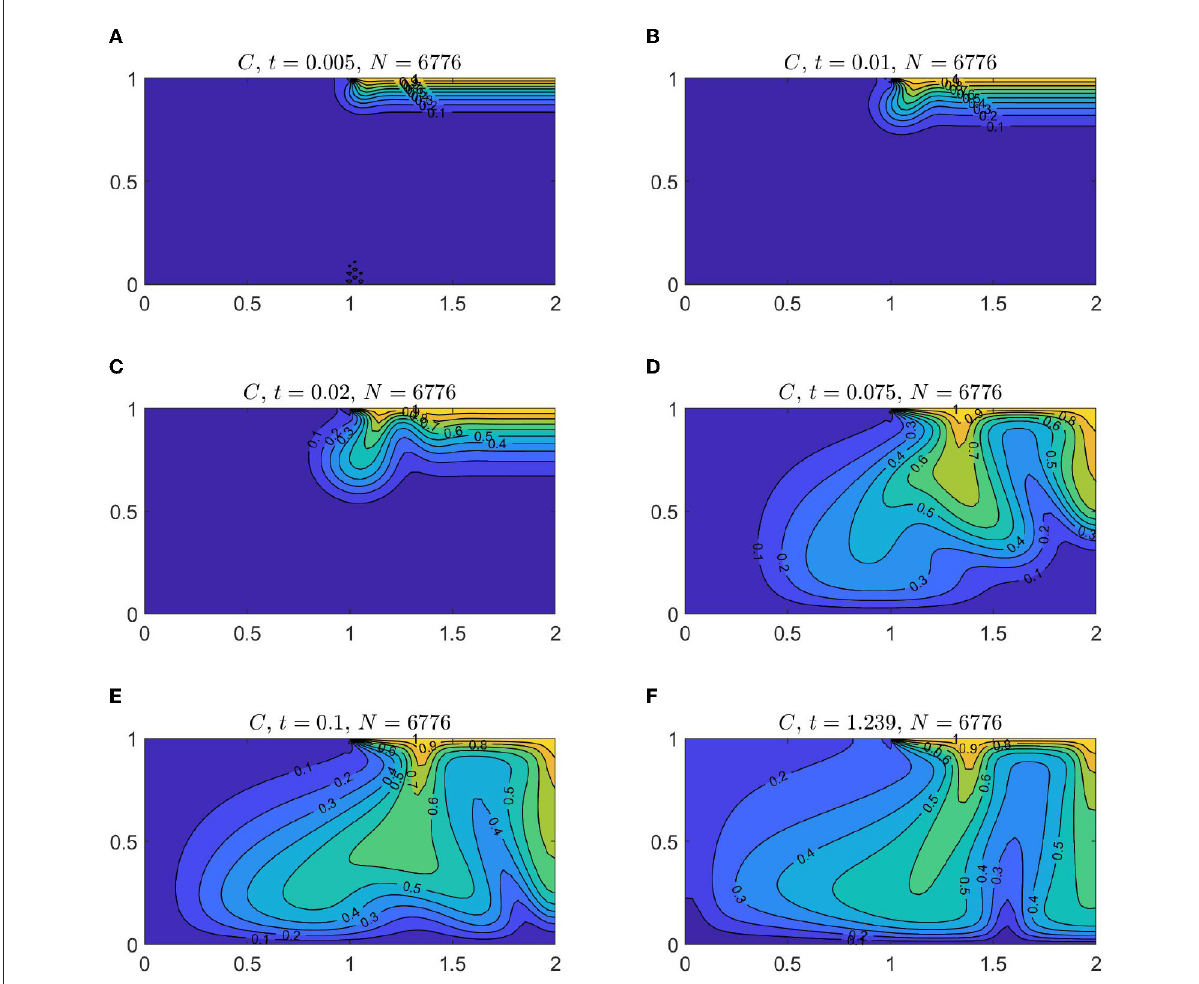
FIGURE16 Concentration distribution for different times. (A) t = 0.005, (B) t = 0.01, (C) t = 0.02, (D) t = 0.075, (E) t = 0.1, and (F) steady-state time t =